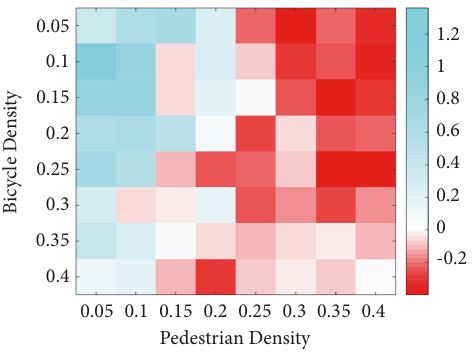
Figure 13: Difference of average influenced bicycle speeds between the scene with harbor-shaped bus stop and conventional bus